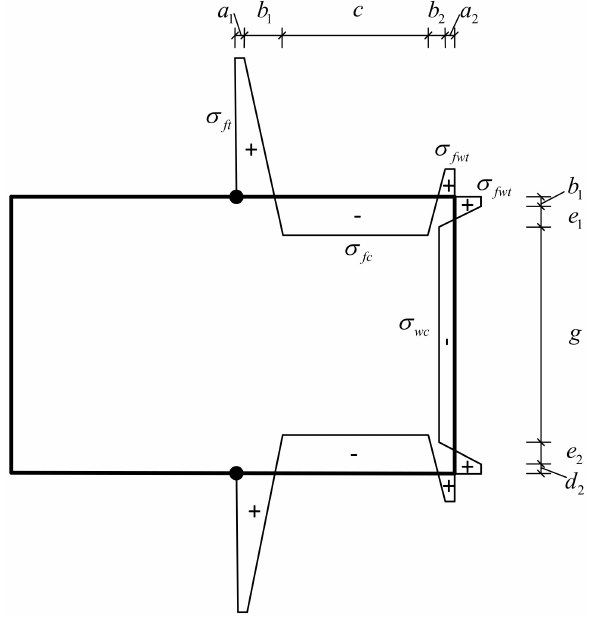
Figure 9. Residual stress model.